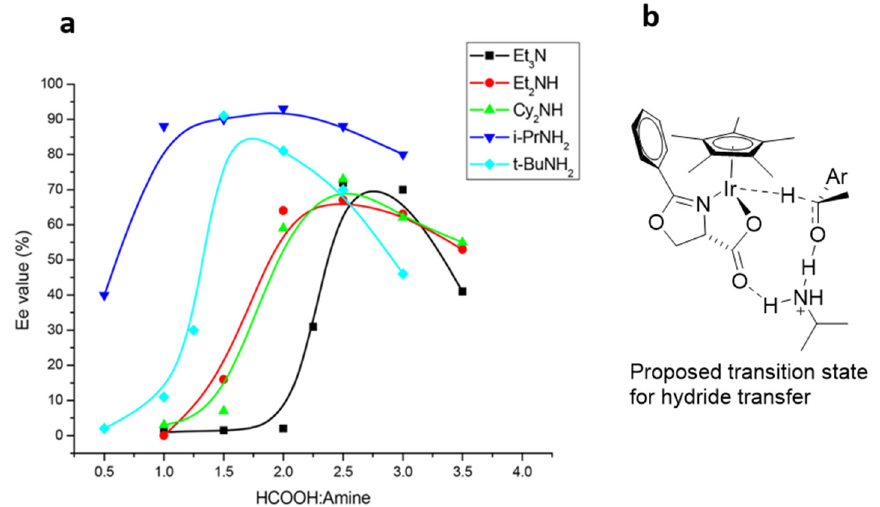
Figure 3. ( a ) Effect of the structure of base and the formic acid/base ratio on the enantioselectivity of the ATH of p -nitro-acetophenone catalyzed by 73 . ( b ) Proposal for the transition state of the hydride transfer ( a ), reprinted with permission from [63]; copyright 2018 American Chemical Society.